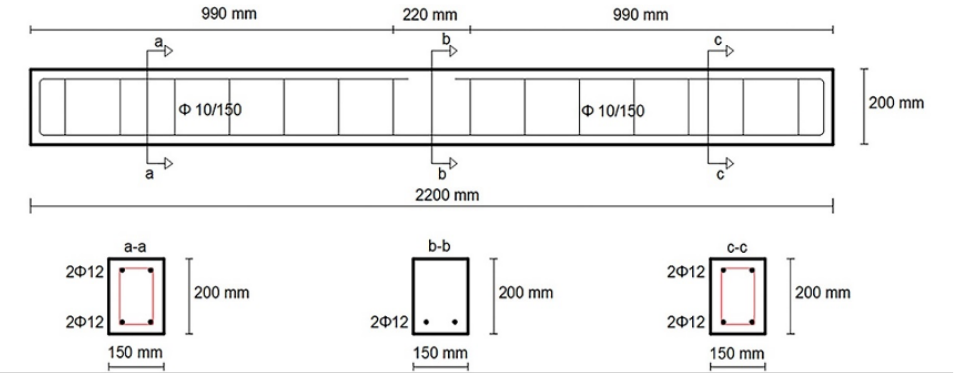
Figure 1. Control Beam.